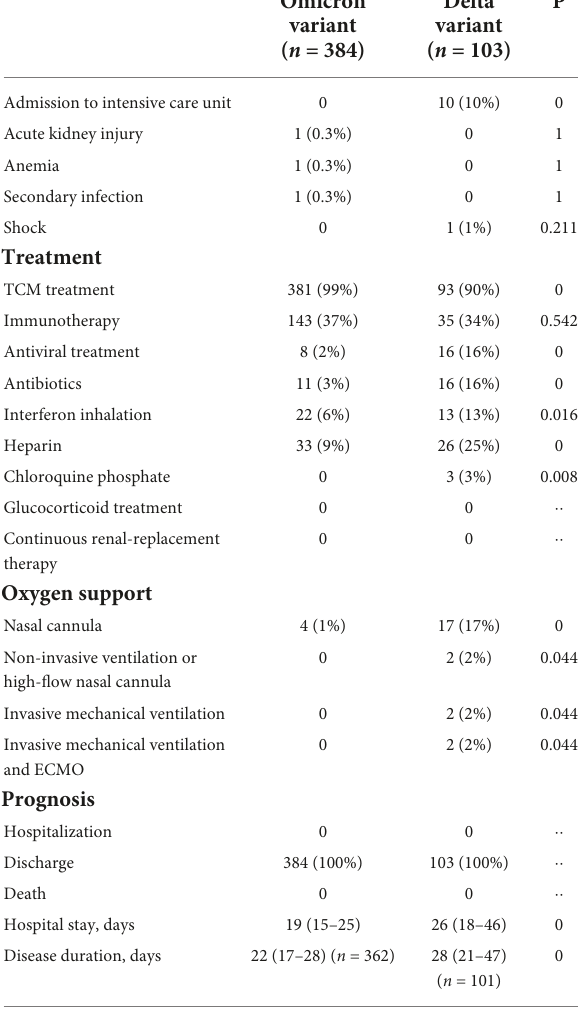
TABLE 3 Treatments and outcomes of patients infected with the Omicron variant or Delta